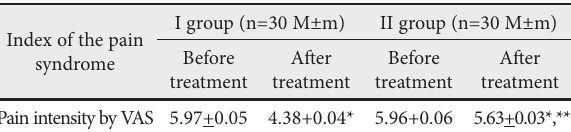
Dynamics of the intensity of the pain syndrome before and after treatment in both